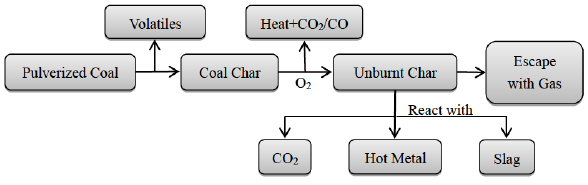
Figure 1: Consumption of pulverized coal in blast